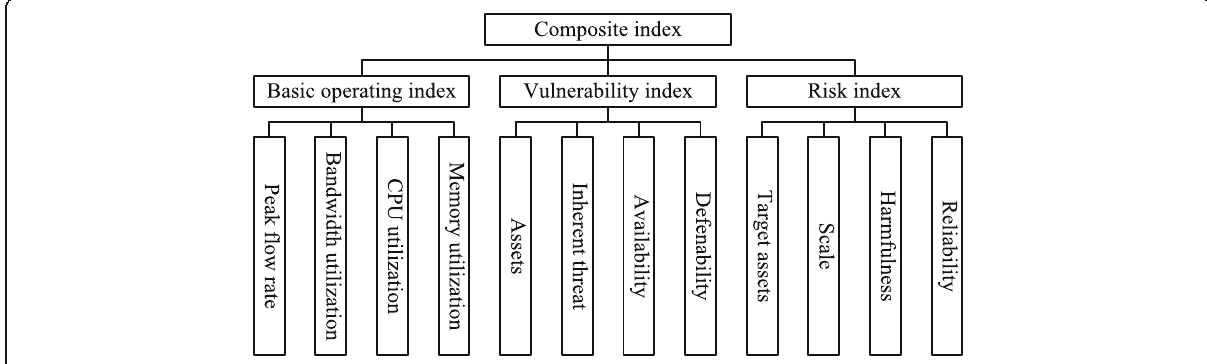
Fig. 11 The index evaluation system based on configuration